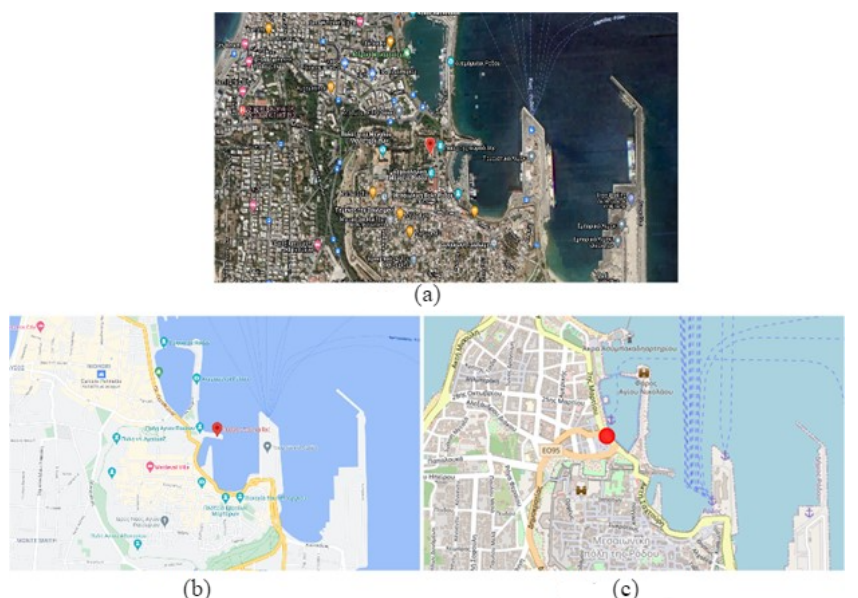
Figure 13. Smart tag and weather stations positions on map: ( a ) Weather Station 1, ( b ) Smart Tag and ( c ) Weather Station